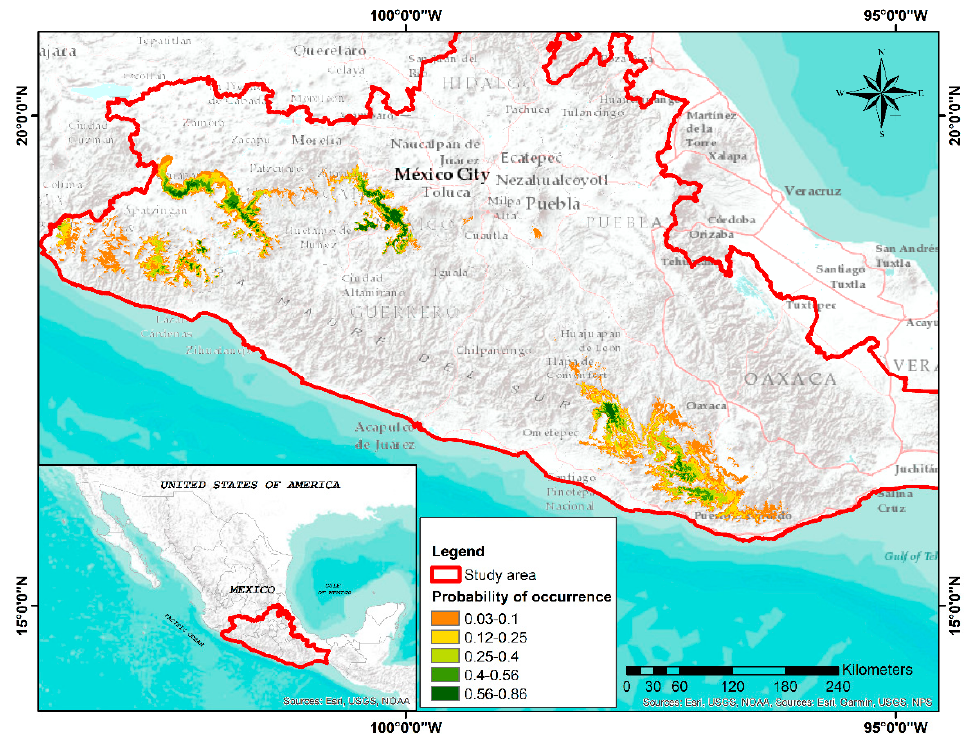
Figure 8. Potential spatial distribution of P. oocarpa using MaxEnt.